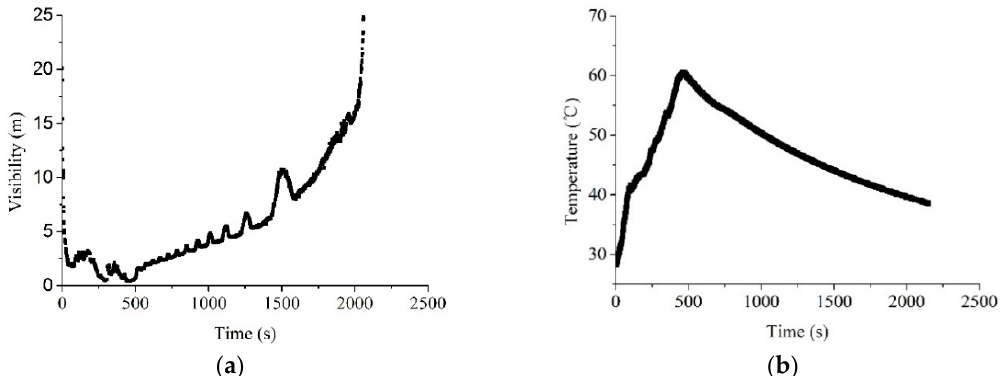
Figure 12. Visibility ( a ) and temperature ( b ) histories for the smoke produced by